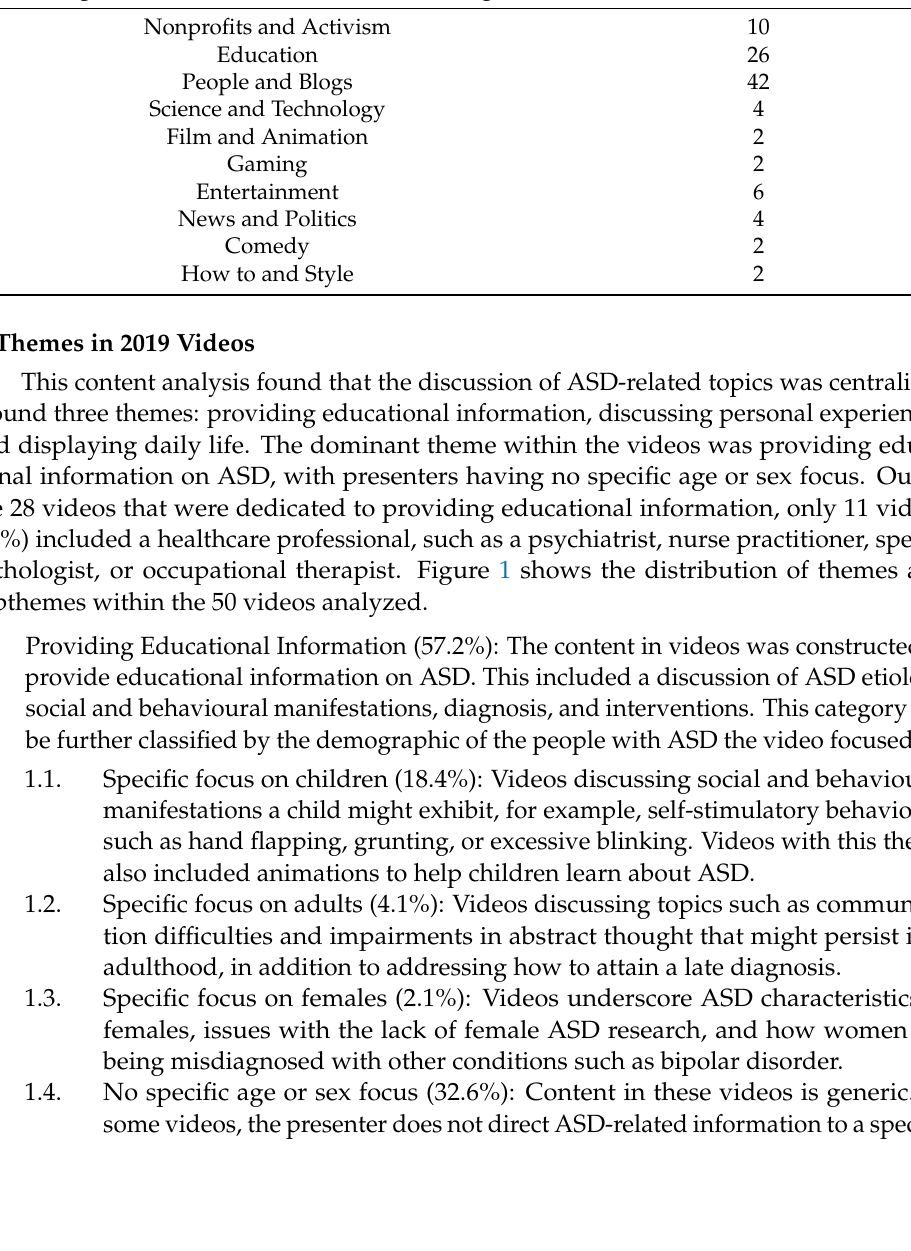
Table 2. Distribution of videos in 10 different categories as labelled by YouTube. n = 59. Percentage of Videos in Different YouTube